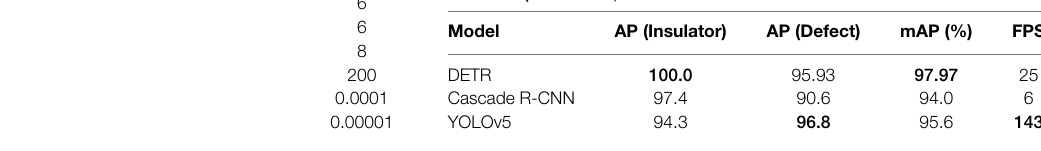
TABLE 5 | Detection performance of different